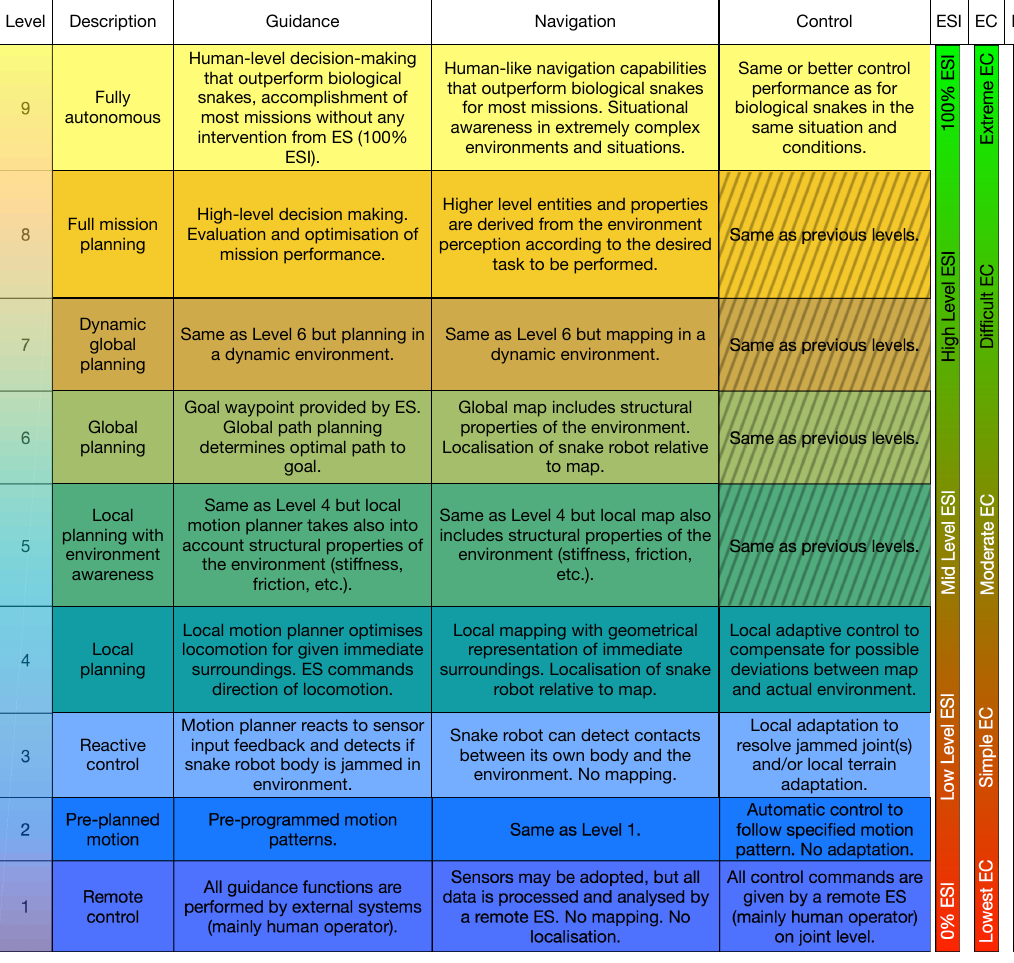
Figure 4. The ATRA framework [7,8] applied to snake robot perception-driven obstacle-aided locomotion with the different levels of external system independence (ESI), of environmental complexity (EC) and of mission complexity (MC). ES refers to “External